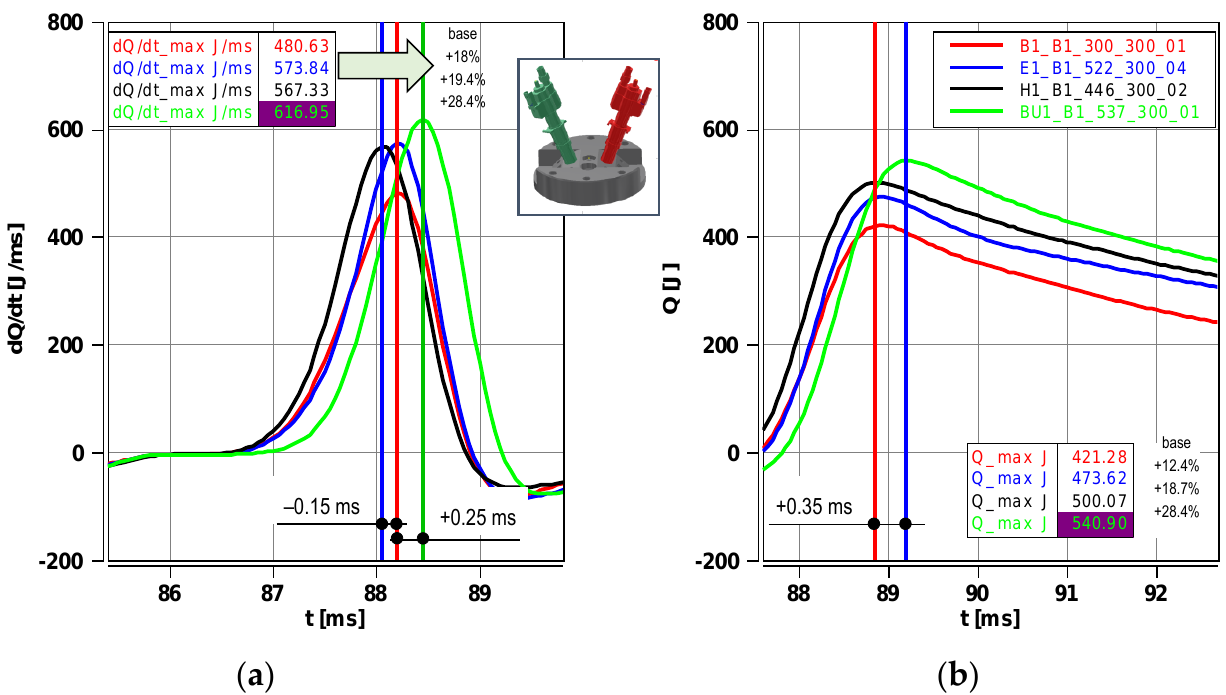
Figure 6. Combustion process indicators (for the injection of various fuels): ( a ) comparison of the time characteristics of the heat release rate in the RCM combustion chamber during the combustion of gasoline with other fuels, along with the maximum values obtained; ( b ) summary of time characteristics of the heat generated in the combustion chamber of a rapid compression machine during the combustion of gasoline with other fuels, with the maximum values of parameters for each of the tested cases.